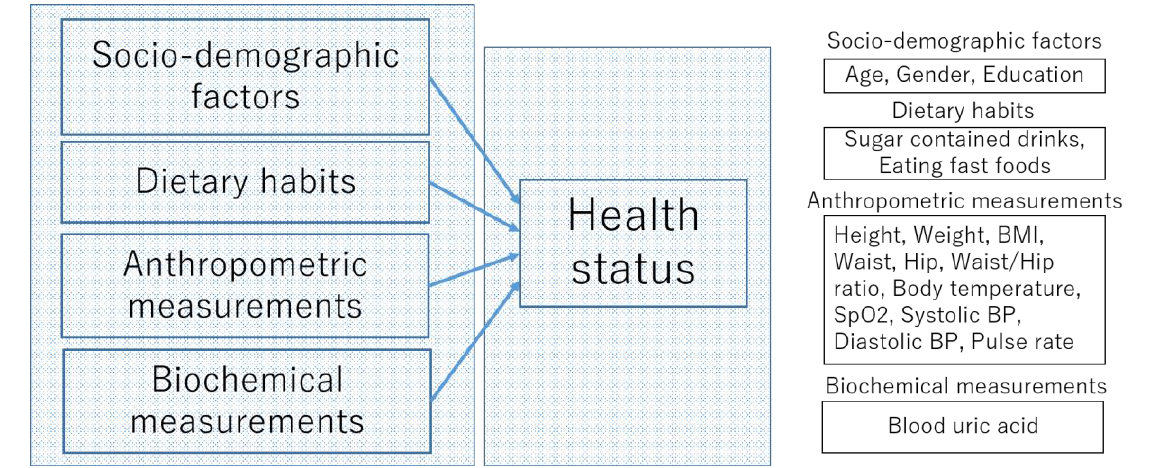
Figure 1. The conceptual framework of the multinomial logistic regression (MLR)